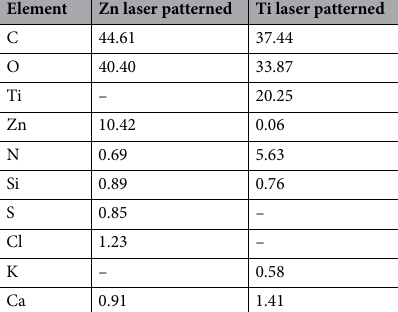
Element Zn laser patterned Ti laser